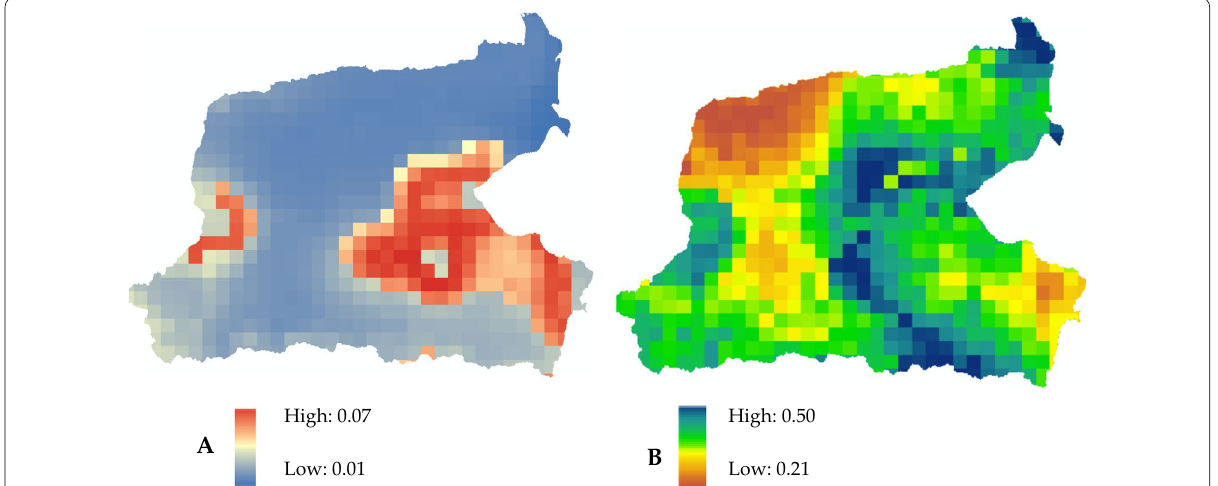
Fig. 4 The Sen’s slope estimator of Man–Kendall from monthly TerraClimate runoff 2001–2020 ( A ), and p -value of Man–Kendall test ( B